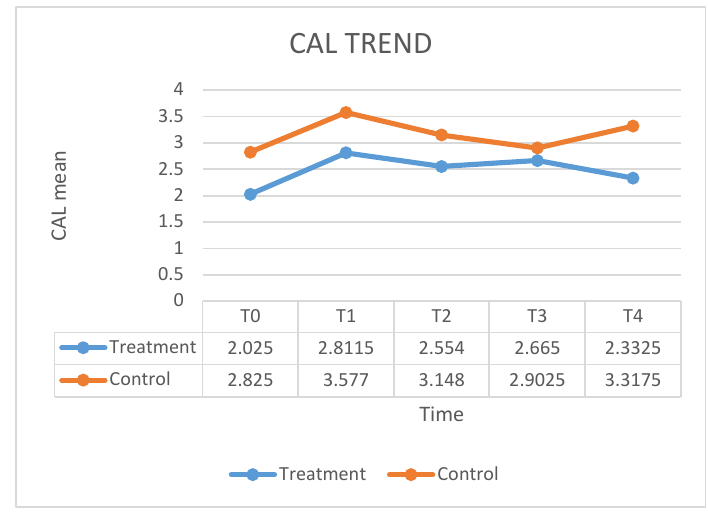
Figure 5. The fluctuation in the CAL means over time. Table 2. Comparison of PI, PDD, CAL, and HbA1C values between SRP + OT and SRP-alone groups by Mann–Whitney U test.